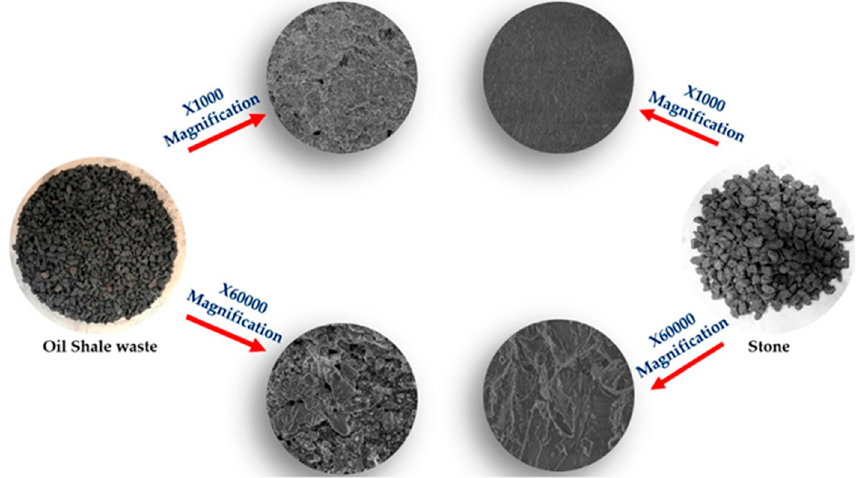
Figure 1. The microscopic appearance of oil shale waste.